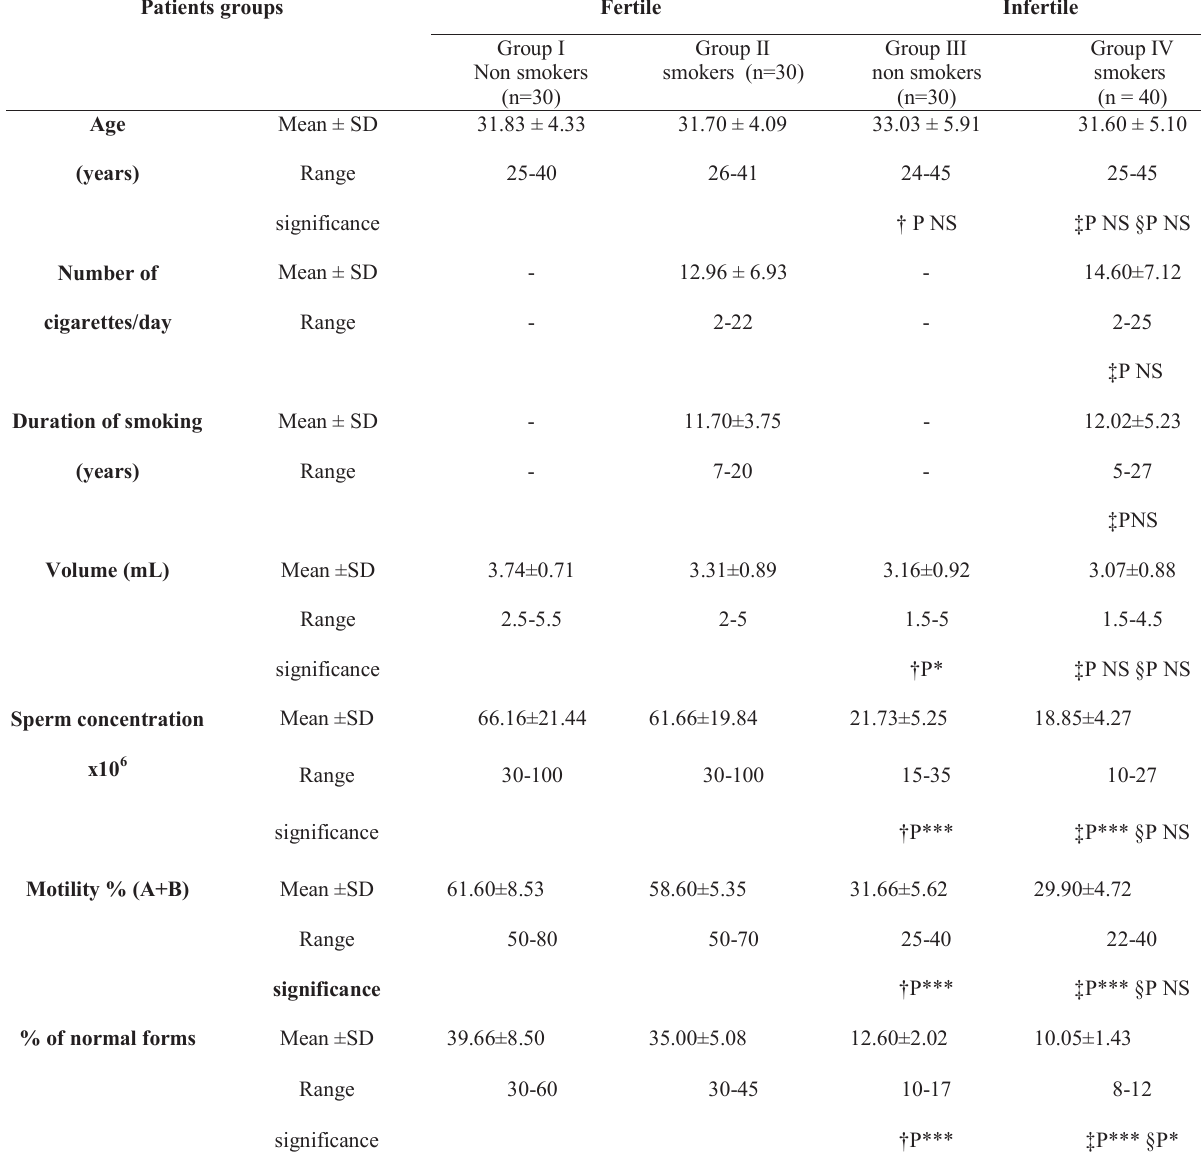
Table 1 - Demographic variables and semen parameters in infertile men and fertile controls.